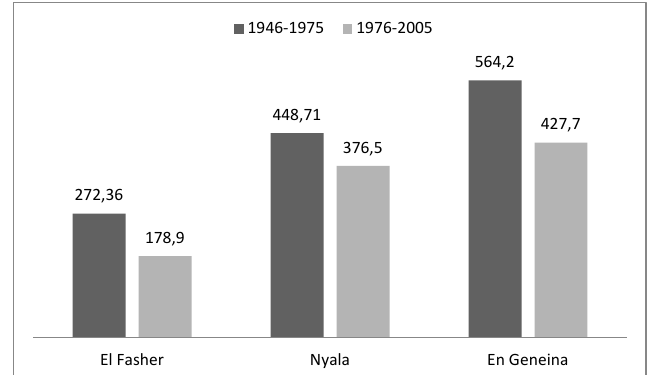
Figure 3. Average precipitation (in mm) in the three Darfuri capitals by time period. Source: Time series constructed on the basis of data from UNEP (2007, Table